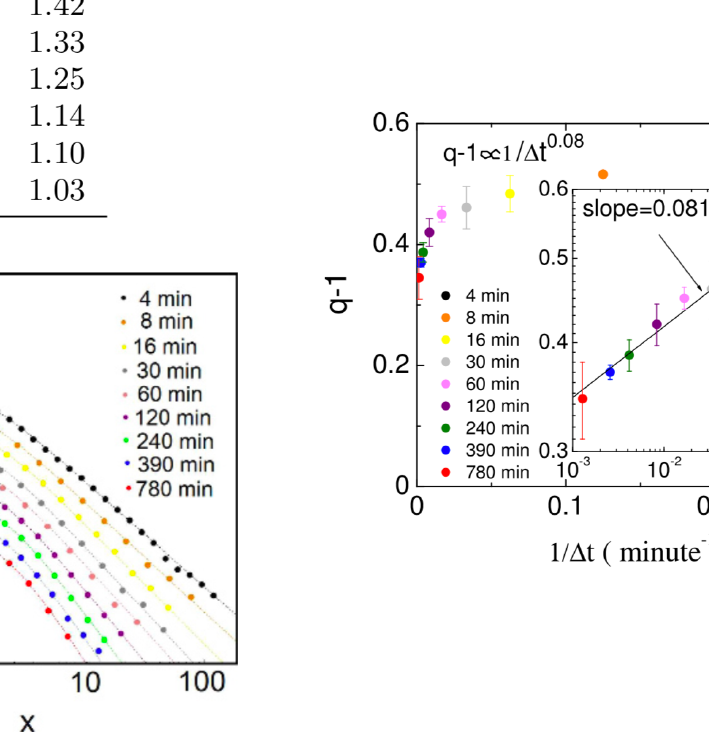
Figure 22. Left panel : Cumulative distributions of absolute normalized returns corresponding to different time scales ∆ t for the 100 American companies with the highest market capitalization (points), and the fitted cumulative q -Gaussian distributions (lines). In order to better visualize the associated results, each q -Gaussian CDF and the respective experimental data have been multiplied by a positive factor c (cid:54) = 1. Right panel : Dependence of the index q on the time scale ∆ t , for the estimated q -Gaussian pdfs of normalized absolute returns in the left panel. Inset: log-log representation exhibiting a power-law dependence of the type q − 1 ∝ ( ∆ t ) − τ , with τ = 0.081 ± 0.004. From